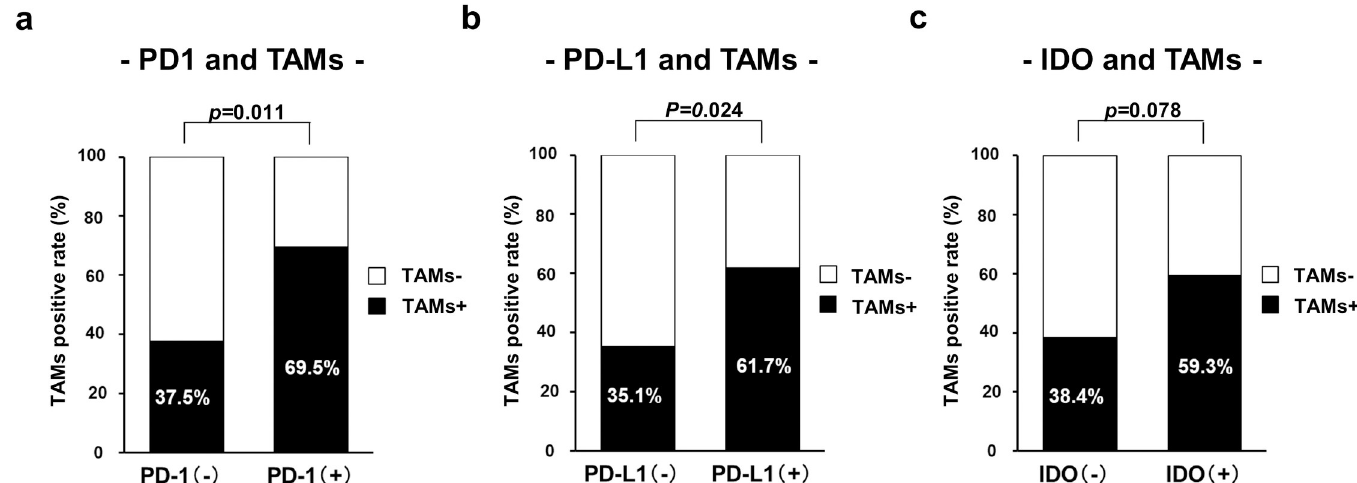
Fig 2. Correlation between TAMs and PD-1, PD-L1, and IDO. Correlation of high density of TAMs with a. PD-1, b. PD-L1, and c. IDO expression in colorectal cancer liver